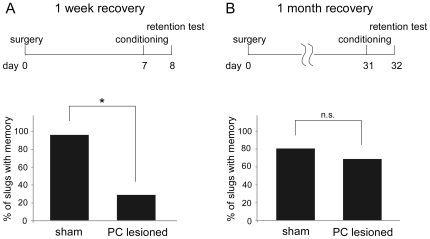
Learning ability recovers 1 month but not 1 week after a PC lesion.(A) PC-lesioned slugs were unable to learn following a 1 week recovery period (n = 28 for sham-operated, n = 34 for PC-lesioned slug) with a significantly smaller percentage of lesioned slugs demonstrating odor-aversion conditioned behavior compared to that of the sham operated slugs. *P<0.001 by χ2-test. (B) PC-lesioned slugs were able to learn following a 1 month recovery period (n = 58 for sham-operated, n = 74 for PC-lesioned slugs) with a percentage of lesioned slugs demonstrating odor-aversion conditioning that was comparable to that of sham operated slugs.